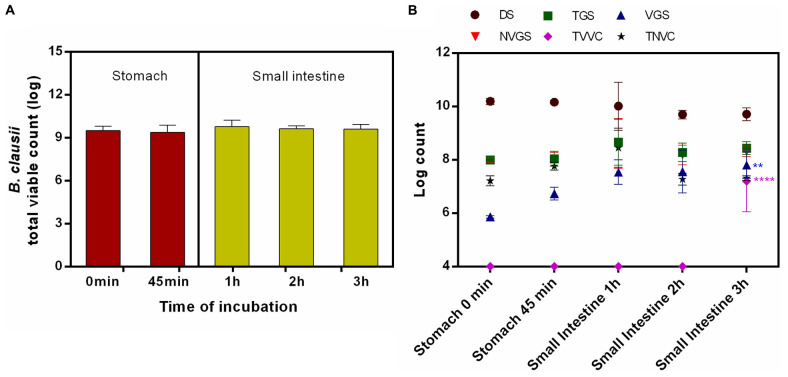
Survival and germination of B. clausii UBBC07 in upper GIT under fasted conditions. (A) Total viable count (TVC) enumerated on agar plate. (B) Log count of dormant spores (DS), total germinating spores (TGS), viable germinating spores (VGS), non-viable germinating spores (NVGS), total viable vegetative cells (TVVC), and total non-viable vegetative cells (TNVC) estimated by flow cytometry. Data are expressed as average ± SD of three independent replicates. **p < 0.01 and ****p < 0.0001.